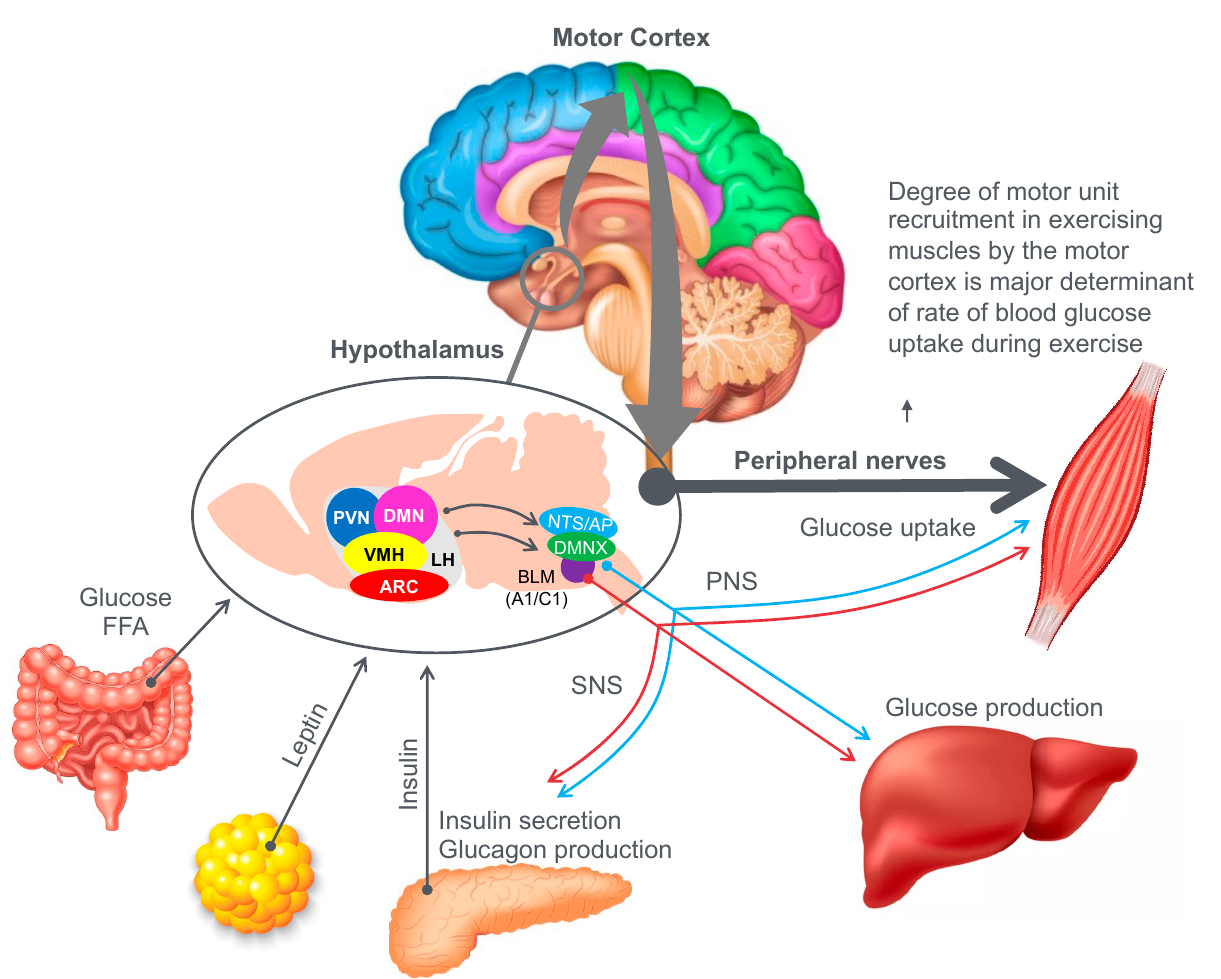
Figure 9. From [46]. Specialized brain areas in the hypothalamus and brain stem (AP, area postrema; ARC, arcuate nucleus; BLM, basolateral medulla; DMN, dorsomedial nucleus; DMNX, dorsal motor nucleus of the vagus; LH, lateral hypothalamus; NTS, nucleus of the solitary tract; PNS, parasym- pathetic nervous system; PVN, paraventricular nucleus; SNS, sympathetic nervous system; VMH, ventromedial hypothalamus) sense peripheral metabolic signals through hormones and nutrients to regulate whole body glucose metabolism. The autonomic nervous system contributes by modulating pancreatic insulin/glucagon secretion, hepatic glucose production and skeletal muscle glucose uptake. During exercise, the major threat to blood glucose homeostasis is the rate of blood glucose uptake by the exercising muscles. It therefore makes sense that the hypothalamic regulators of blood glucose homeostasis must also influence the degree of motor unit recruitment that is allowed in the exercising limbs, specifically to ensure that hypoglycaemic brain damage does not occur during especially prolonged exercise. Adapted, modified and redrawn from the original in [46] with the addition of the action of the hypothalamic → motor cortex → spinal cord → peripheral nerve → skeletal muscle homeostatic reflex